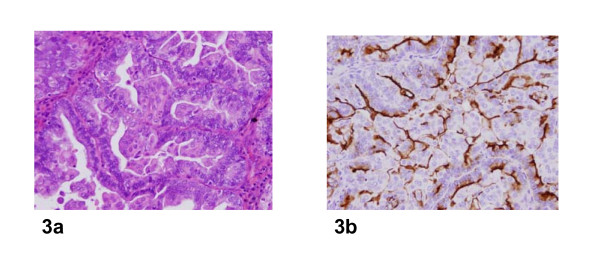
A, Endocervical adenocarcinoma (H&E, x20); B, MUC1 immunostain in endocervical adenocarcinoma showing apical staining pattern (x20).